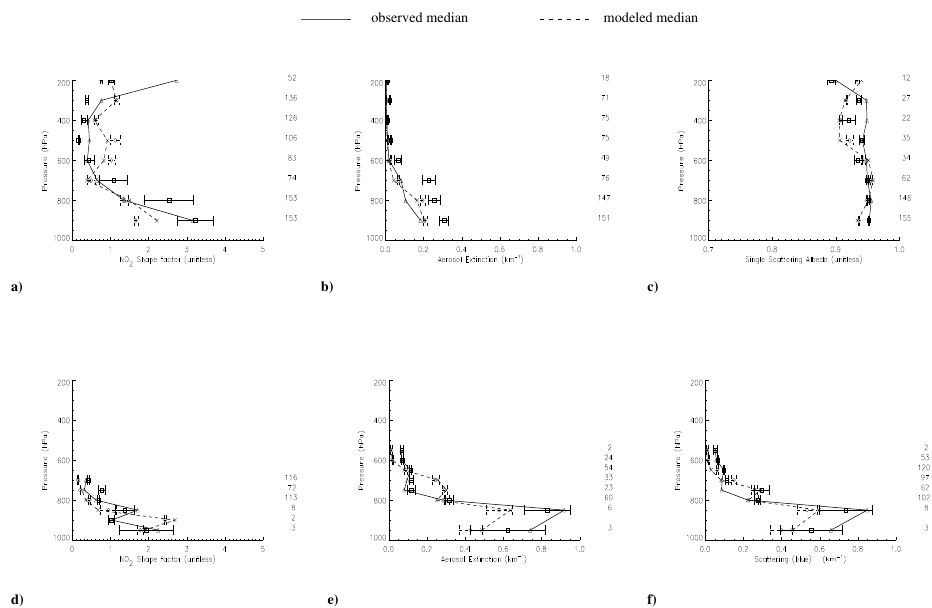
Figure 1. Simulated and observed vertical profiles of NO 2 shape factors (a) , aerosol extinction coefficient (440nm) (b) , and single scattering albedo (440nm) (c) during ARCTAS, and NO 2 shape factors (d) , aerosol extinction coefficient (440nm) (e) , and aerosol scattering coefficient (440nm) (f) during DABEX. Modeled median values (dashed line) are represented by crosses and observed median values (solid line) by triangles. Modeled mean values are represented by diamonds and observed mean values by square. Bars indicate the standard error of the mean at each altitude level. Table 2. FAAM BAe-146 research payload during DABEX for the species considered in this study. Species,